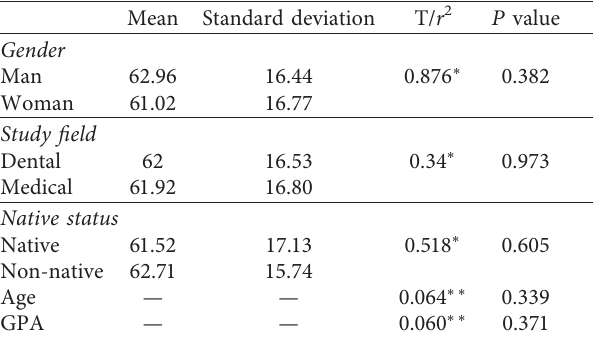
Table 2: The relationship between CDMSE and academic/demo- graphic